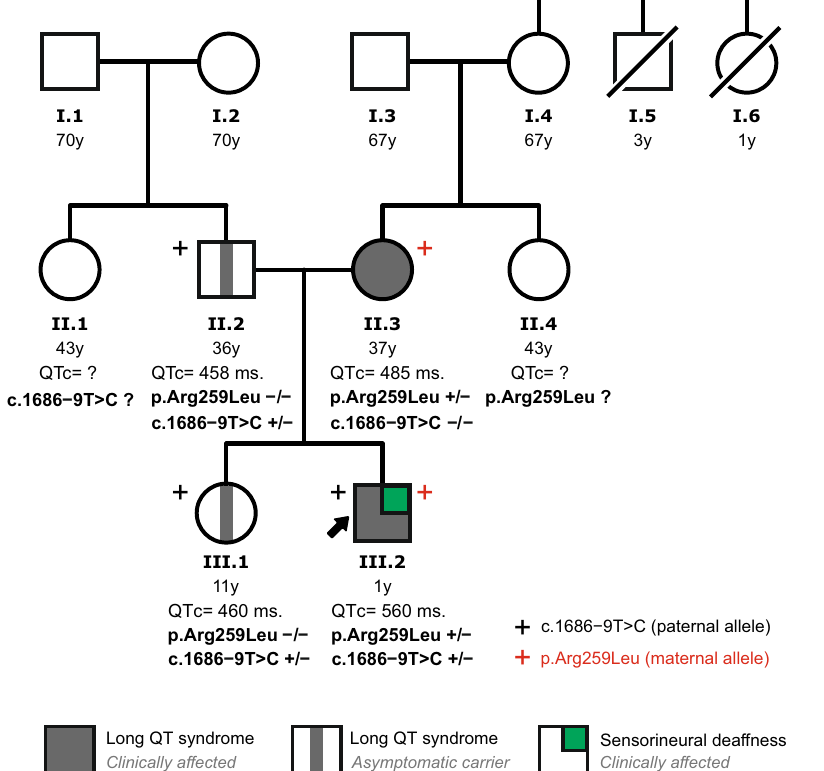
Fig. 4 Family pedigree of the index patient. Available KCNQ1 genotype and clinical data are shown. Arrow indicates the index